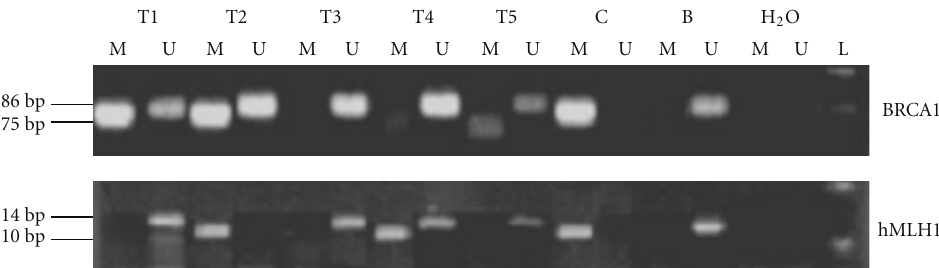
Figure 1: Electrophoresis of PCR products spanning the BRCA1 and hMLH1 promoters from bisulfite-treated DNA in breast cancer tissues. Each lane contains products generated from separate PCR reactions using primers specific for unmethylated (U) or methylated (M) DNA template. Fully methylated DNA from Active Motif and Blood from healthy individual used as a positive control (C) for methylated and unmethylated DNA (B). The lanes marked (H 2 O) indicates water only without the addition of DNA and (L) 100-bp ladder as molecular weight markers